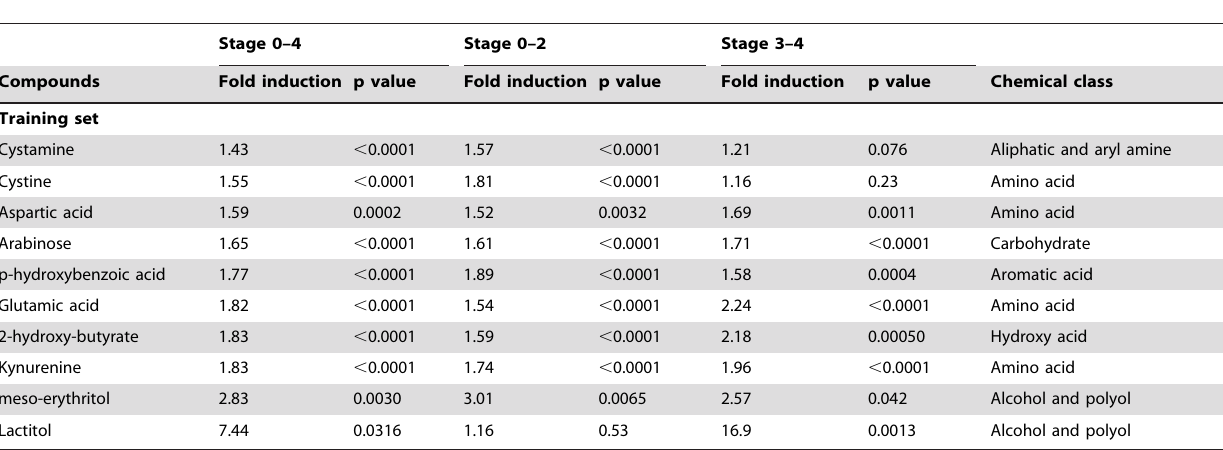
The 7 metabolites subjected to multivariate analysis using the stepwise variable selection method are listed in Table 3. Among these metabolites, arabinose, meso- erythritol, and lactitol are excluded, because they are frequently consumed in the diet. The concentration of each metabolite in the colorectal cancer patients with stage 0–4, stage 0–2, or stage 3–4 disease at the training set was compared with that detected in the healthy volunteers, and the fold induction was calculated. P values were evaluated using the Mann-Whitney U test, and p values of less than 0.05 were considered to indicate a significant difference.